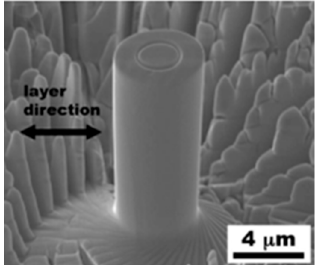
Figure 9. SEM micrograph of the micropillar of Cu/Nb multilayer with h = 5 nm. The layer interfaces are perpendicular to the cylinder axis [5].